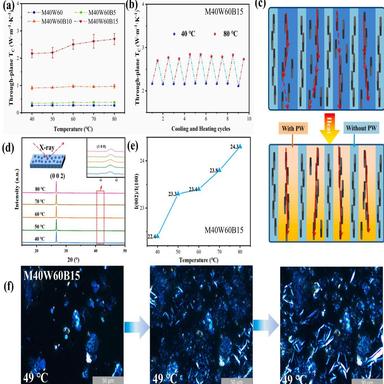
(a) The through-plane thermal conductivity of M40W60Bx PCMs at different temperatures; (b) the changes in through-plane thermal conductivity changes during cooling and heating cycles between 40 ◦C and 80 ◦C; (c) the construction of the thermal conduction pathway of M40W60Bx during the solid–liquid phase change process; (d) XRD patterns of the M40W60B15 sample at varying temperatures; (e) the variation trend of I (0 0 2)/I (1 0 0) during the temperature rises from 40 ◦C to 80 ◦C; (f) POM images of the isothe